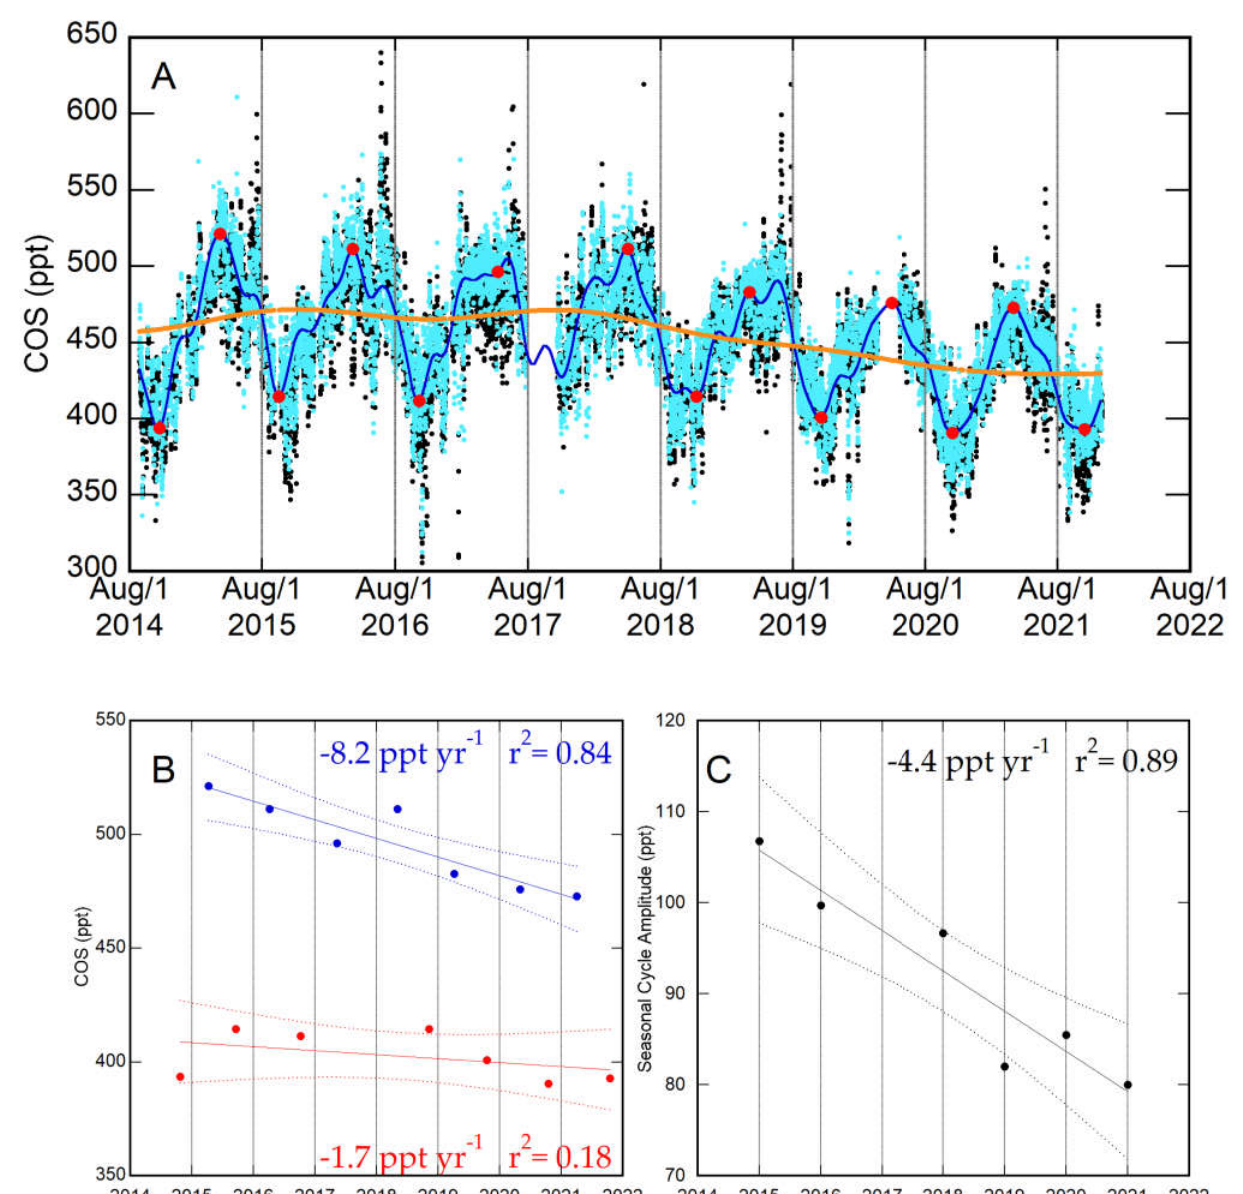
Figure 2. The GIF COS time series (2014–2021) analyzed using the CCGvu curve fitting procedure (( A ) seasonal variations in the smooth curve (blue curve) calculated solely from daytime data ((11–17 h UTC), cyan dots) where the spring maximum and autumn minimum are depicted by red dots; the long-term trend depicted in orange, was also calculated from daytime data). May 15th was set as the upper limit for the detection of the spring maximum, see text. Night-time data (22–04 h UTC) are depicted in black. A few data points over 650 ppt were removed to better visualize the seasonal variability in COS. Annual trends in the spring maximum and autumn minimum (( B ) in blue and red dots, respectively) and in the seasonal cycle amplitude ( C ) are shown, including the 95% confidence